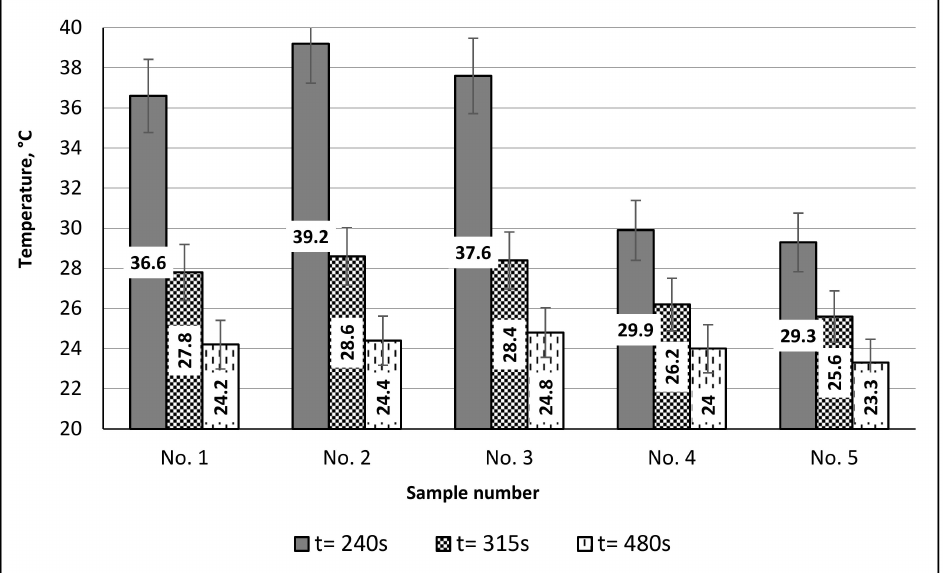
Figure 7. Rate of heat absorption (at time 240 s) of knitted structures of socks by exposure to a 250 W IR lamp, and heat retention (at times of 315 s and 480 s) after irradiation.